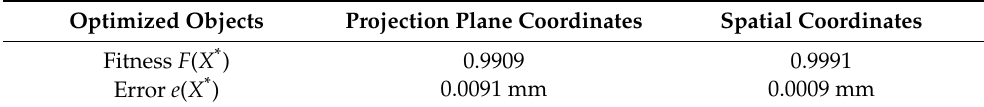
Table 4. Comparison of the results of the two optimizations.